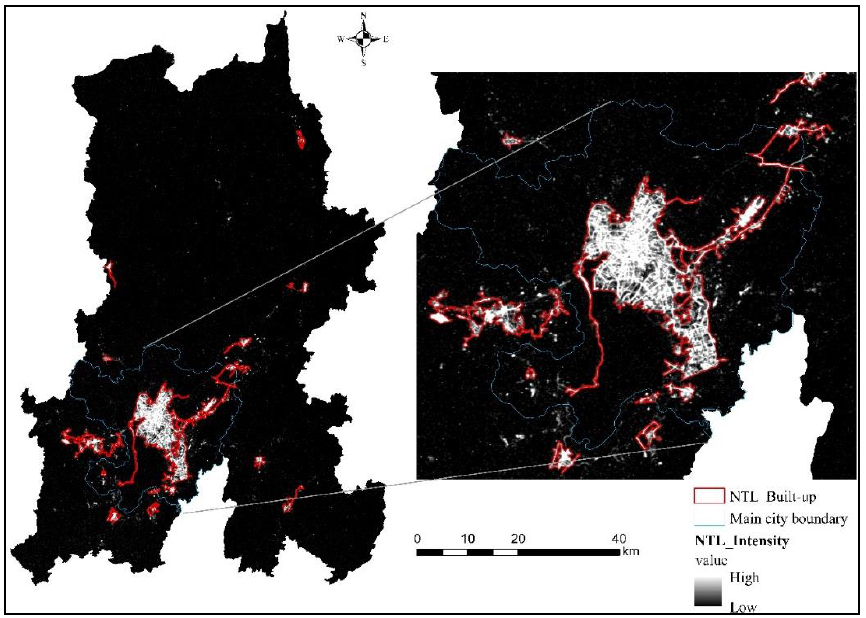
Figure 8. Results of urban built-up areas identified by NTL.